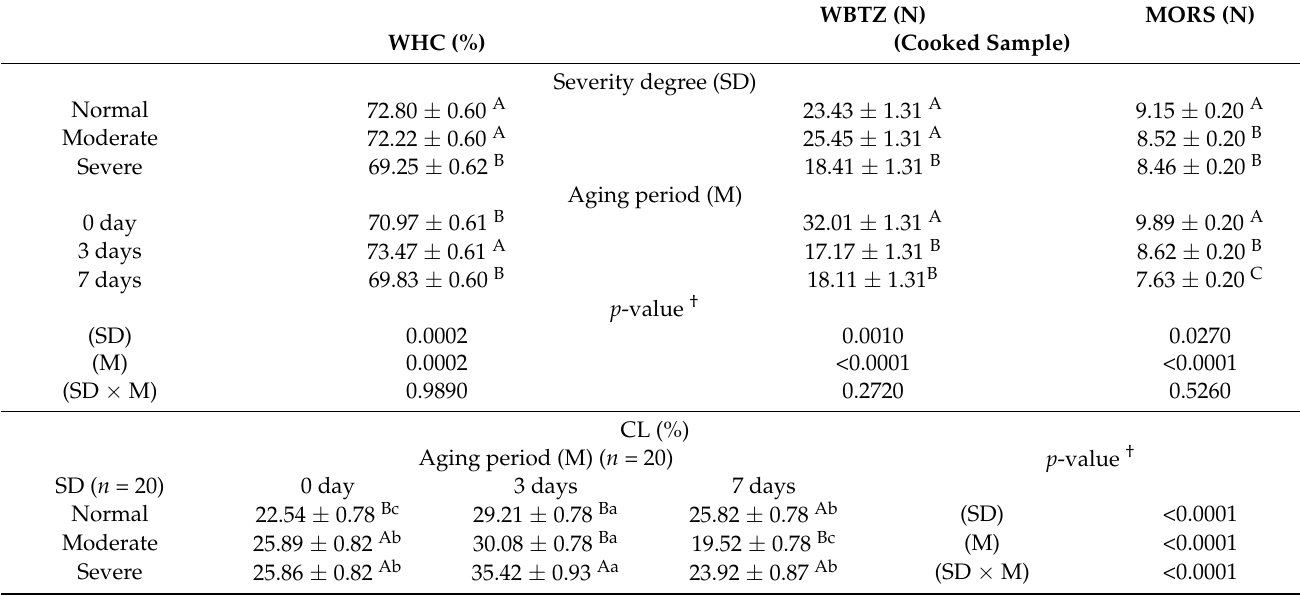
Table 2. Mean values for water-holding capacity (WHC), shear force through Warner–Bratzler (WBTZ) and MORS devices (both in cooked samples), and cooking weight loss (CL) of breast meat from broilers affected by wooden breast myopathy and maturated for up to 7